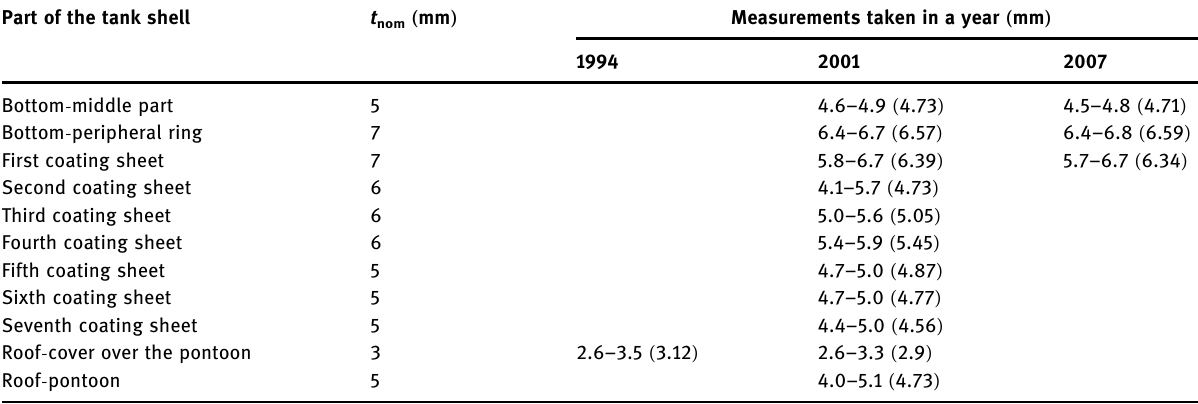
Table 4: Sheet thicknesses measured at di ff erent times in di ff erent locations of the tank number 4 steel shell Part of the tank shell t nom ( mm